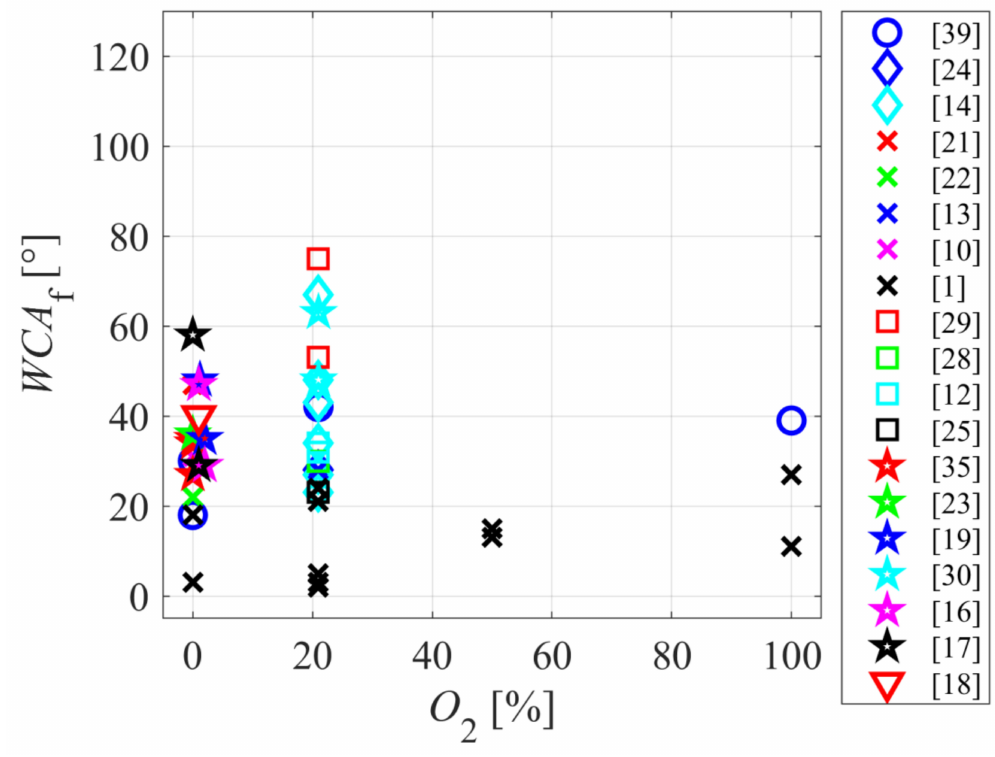
Figure 8. The final water contact angle versus the concentration of oxygen in the original gas